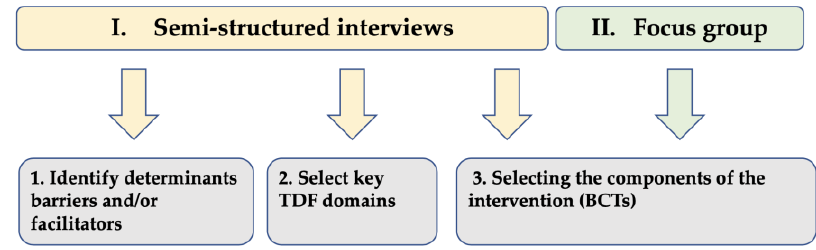
Figure 1. Steps of the qualitative